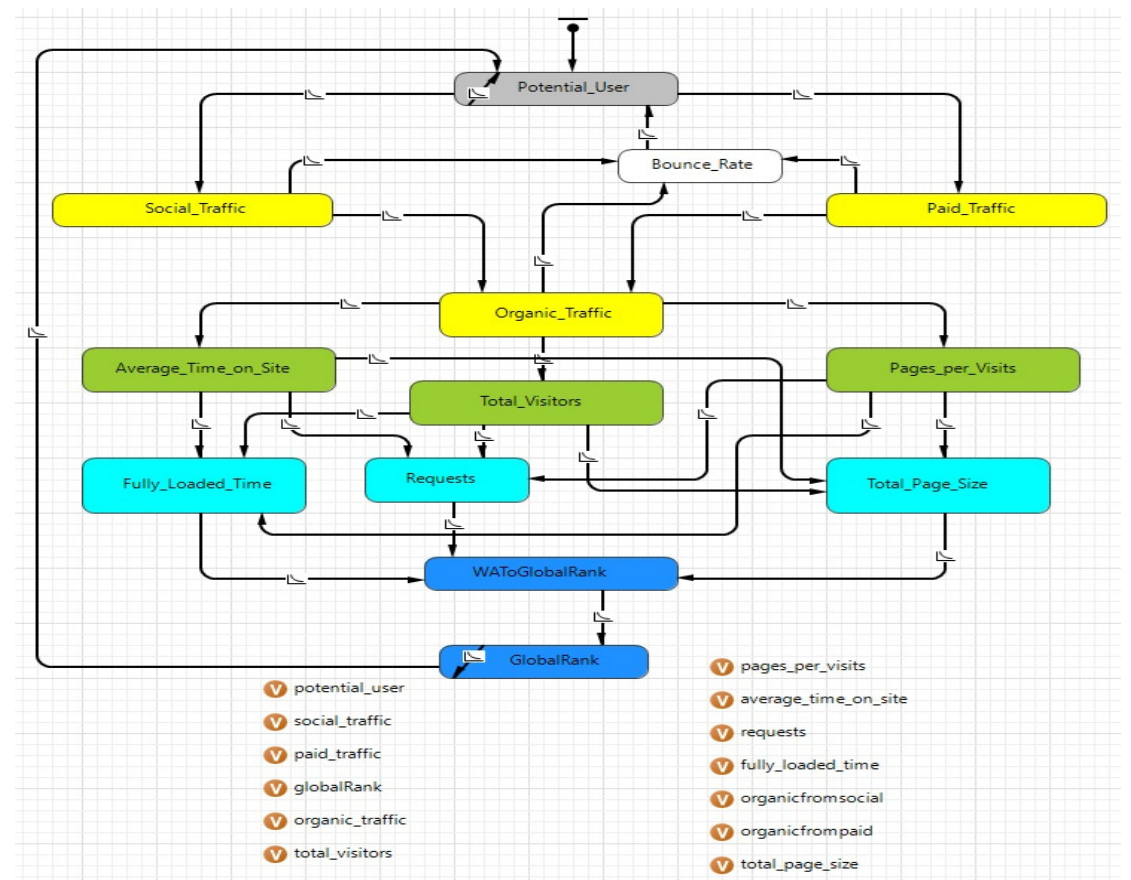
Figure 5. Agent-Based simulation